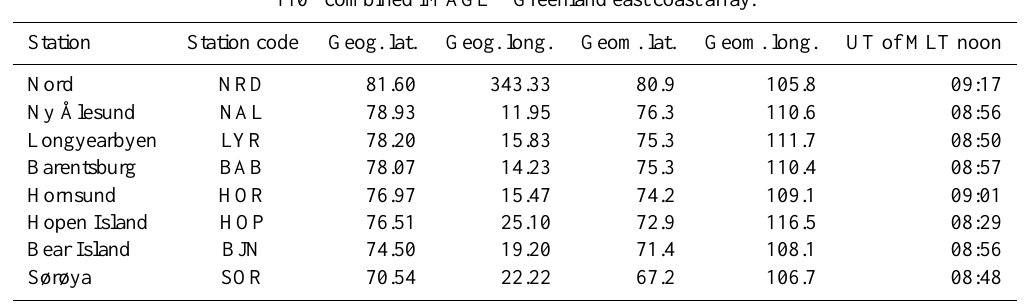
Table 1. List of stations used in the study. Corrected geomagnetic coordinates and UT of local magnetic noon (MLT) have been computed for an altitude of 100km using the NSSDC web facility (http://nssdc.gsfc.nasa.gov/space/cgm/cgm.html). 110 ◦ combined IMAGE – Greenland east coast array.